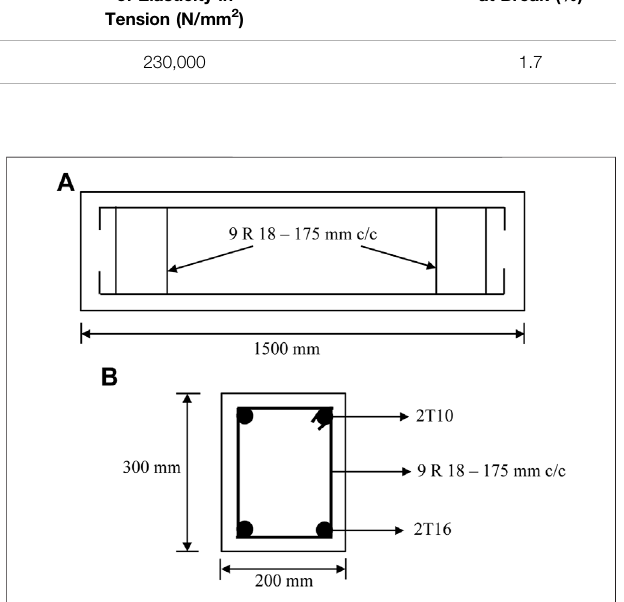
FIGURE 3 | Details of the beam specimen (A) the side-view (B) the section view (unit in